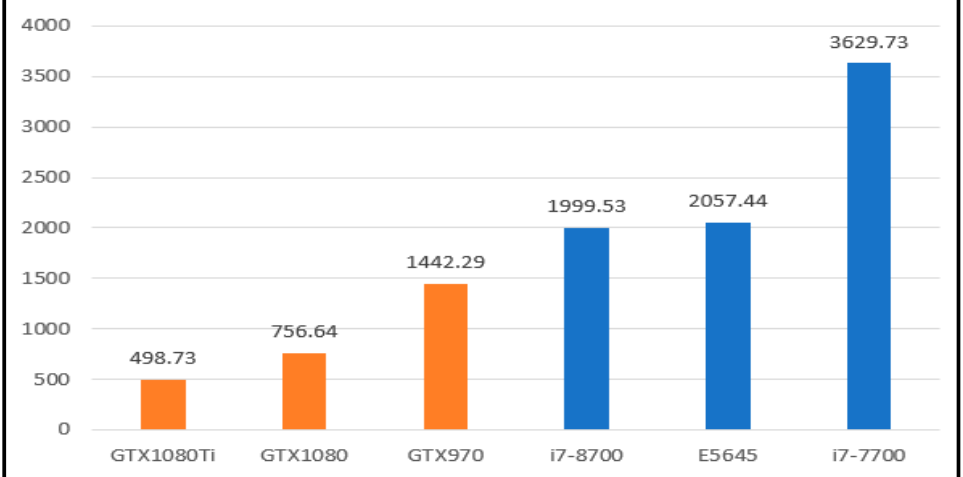
Figure 12. Cost of Tip Select .